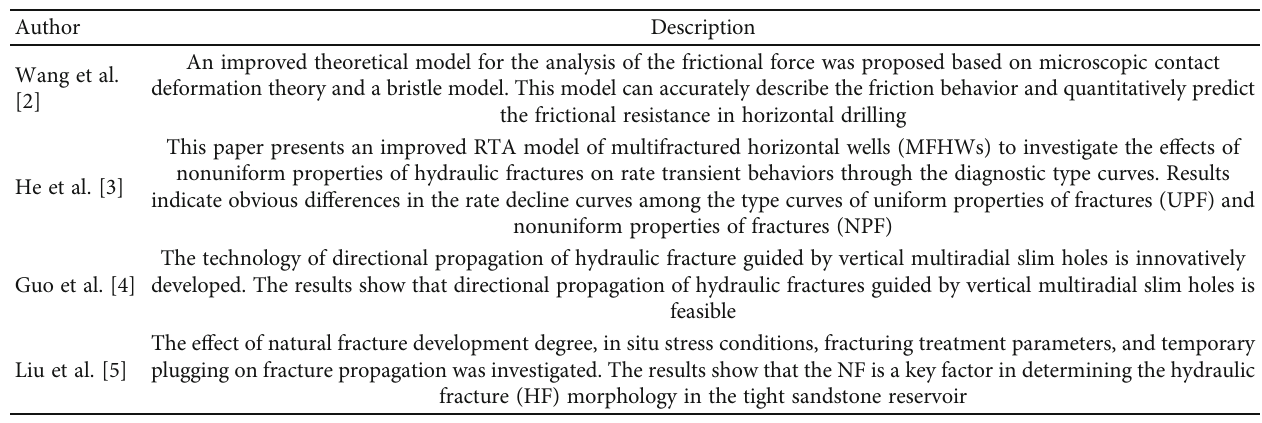
Table 1: Work done by researchers on hydraulic fracturing.